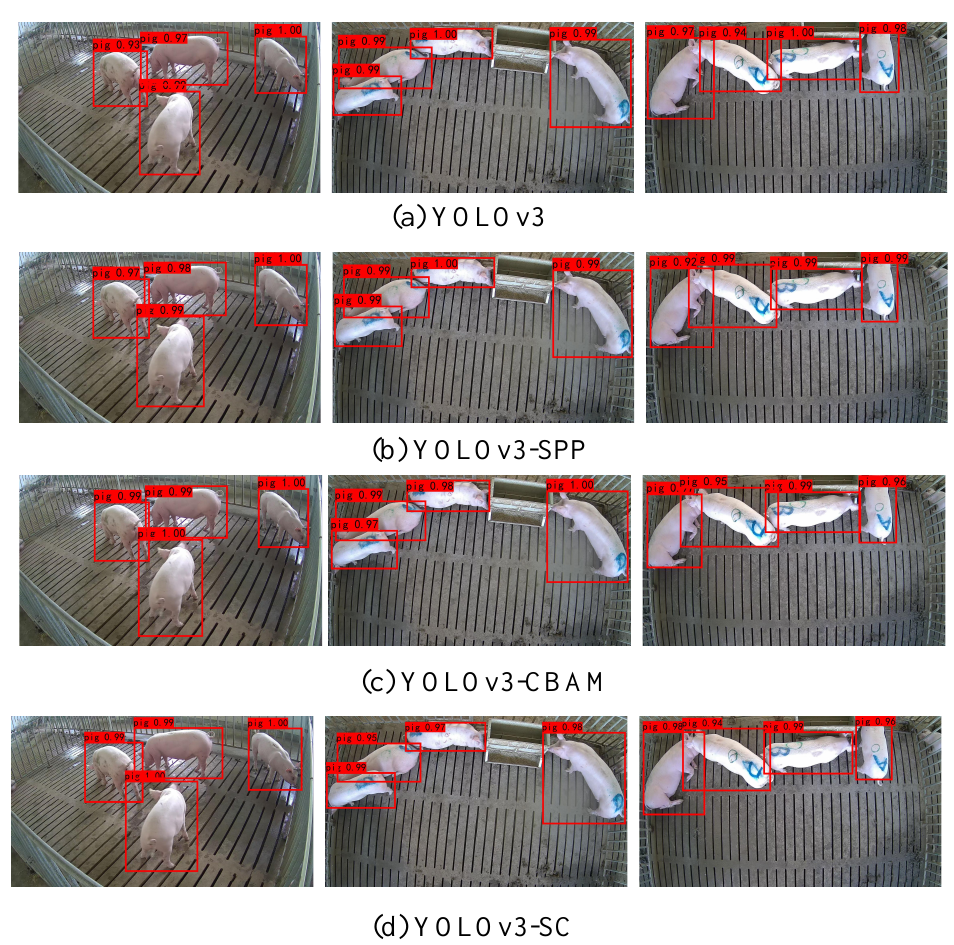
Figure 6. The detection results of different